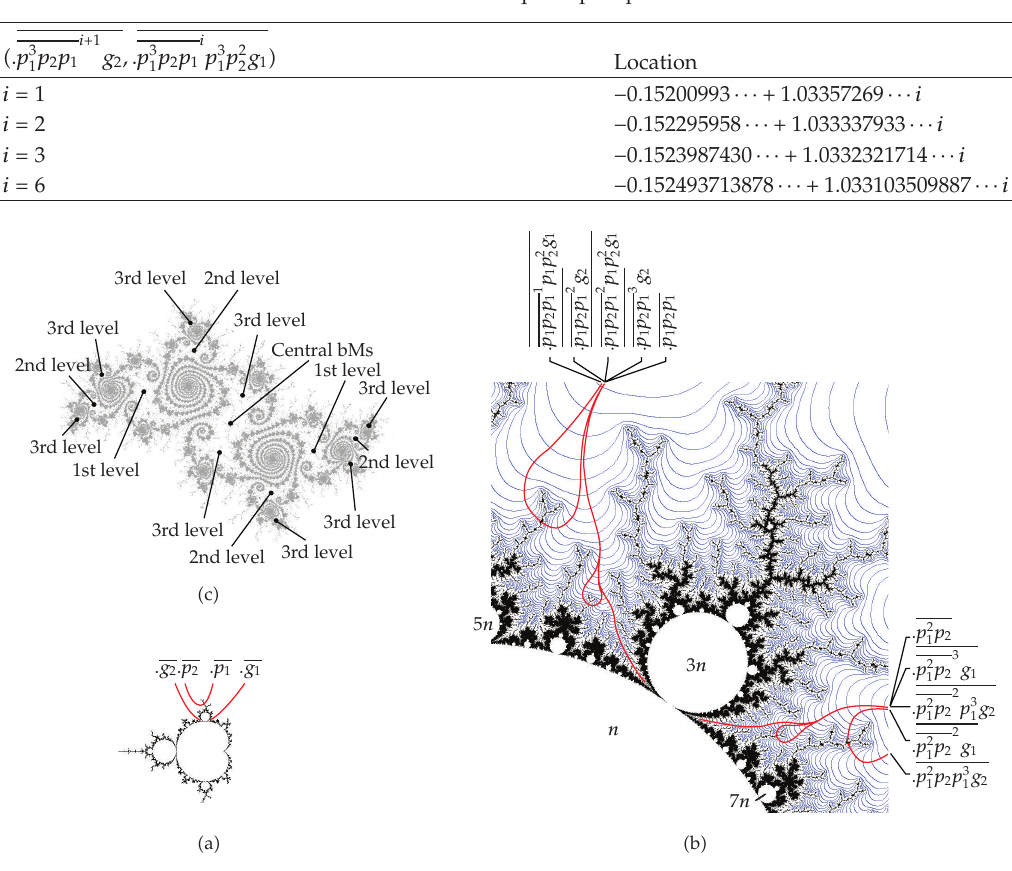
i i (cid:2) 1 p 2 p 3 g 2 ,.p 2 p 2 g 1 (cid:5) . (cid:4) a (cid:5) External rays of the parent and the 1 1 1